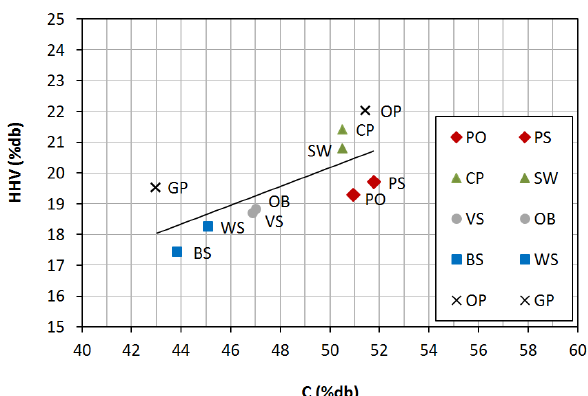
Figure 2. Relationship between carbon content ( C ) and high heating value ( HHV ).